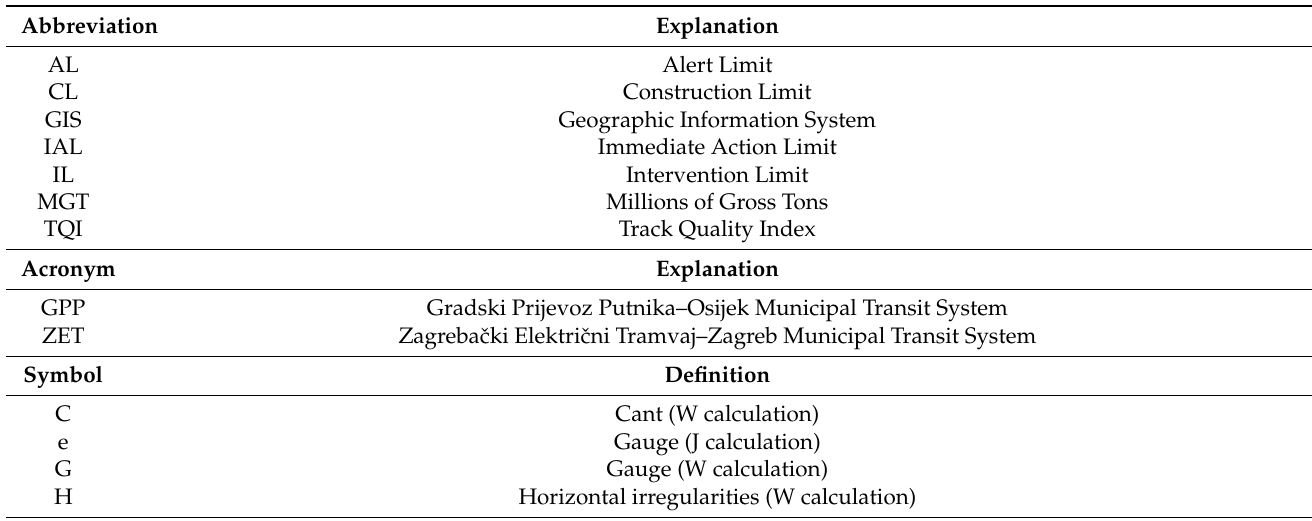
Table A1. List of abbreviations, acronyms, and